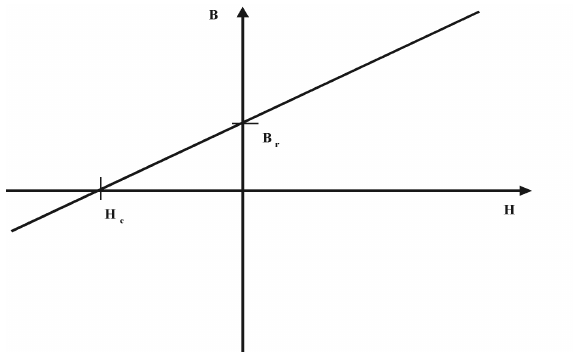
Figure 4: Permanent Magnet model behavior